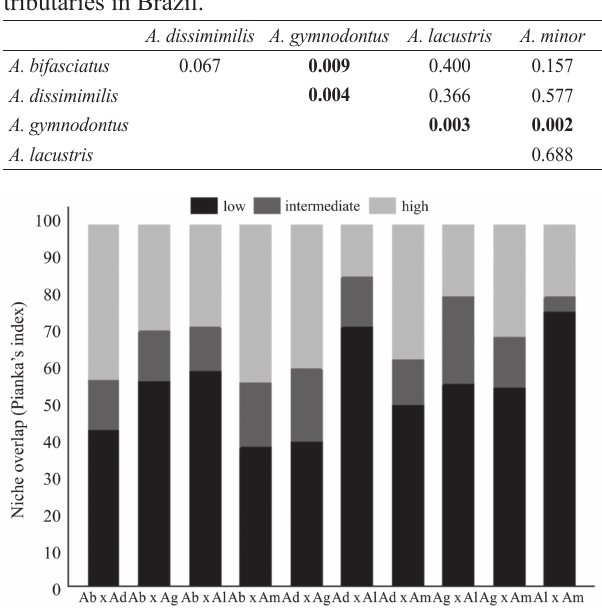
Fig. 4. Relative frequency (%) of the diet overlap index of Astyanax species pairs in the Low Iguaçu River and tributaries in Brazil. Ab= A. bifasciatus ; Ad= A. dissimilis ; Ag= A. gymnodontus ; Al= A. lacustris ; Am= A. minor. Low < 0.39; intermediate =0.40-0.59; high >